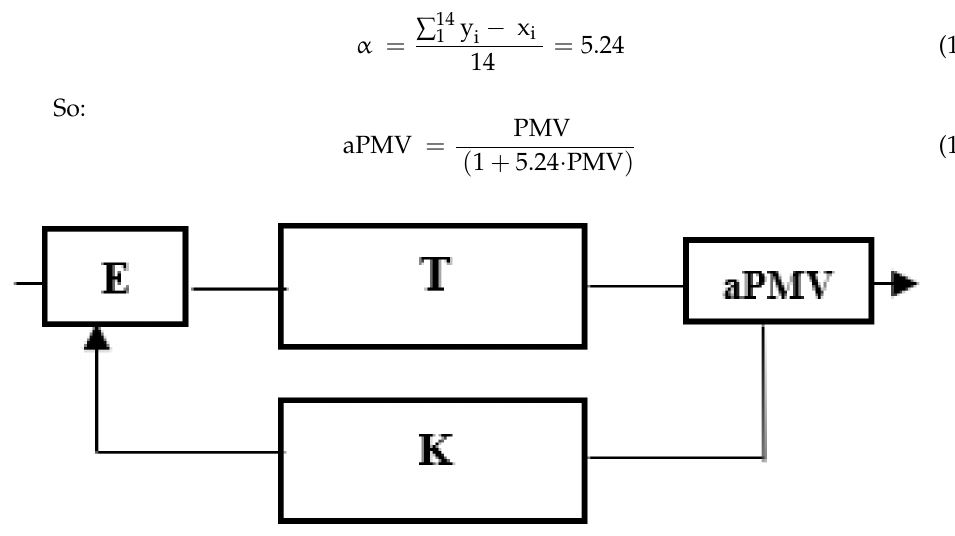
Figure 13. Thermal comfort adaptive model mechanism modified from